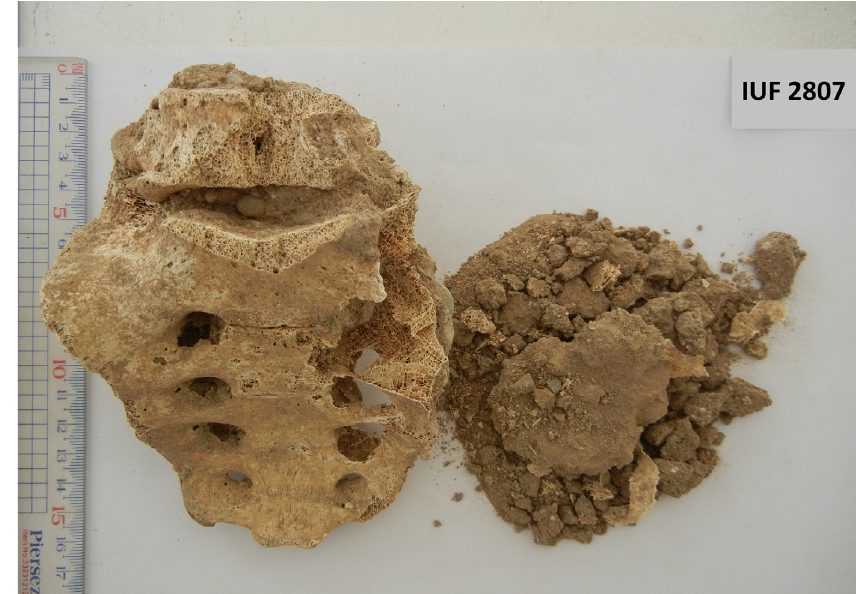
Figure 2. A sacrum showing foramina from which soil samples were examined (burial IUF 2807).